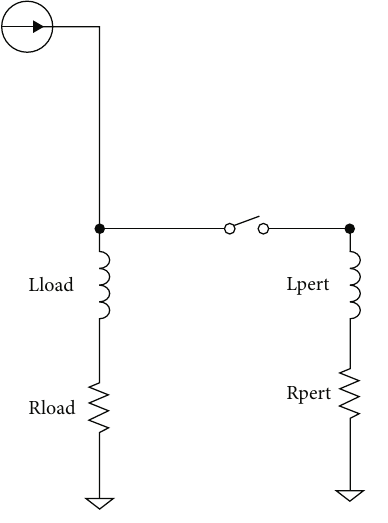
Figure 8: LCL fi lter circuit.